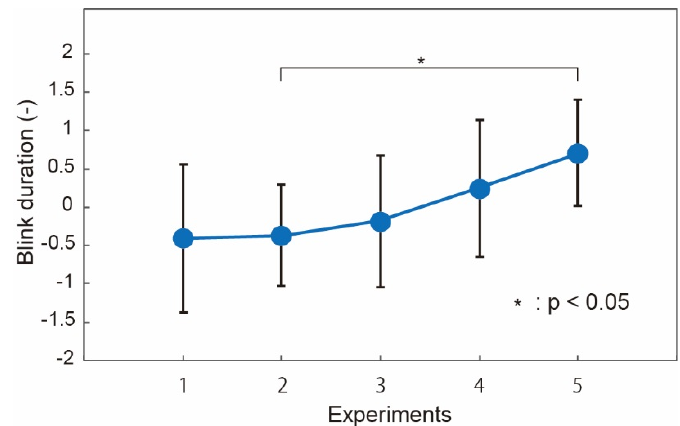
Figure 9 . Blink duration for the subjects who did not have a low level of awakeness. “ p ” represents the p -value in statistics hypothesis testing.